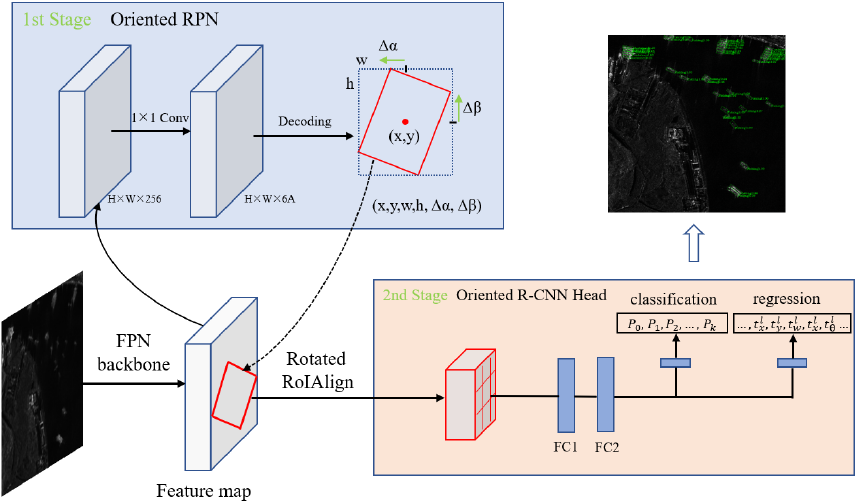
Figure 17. The network architecture of Oriented R-CNN.